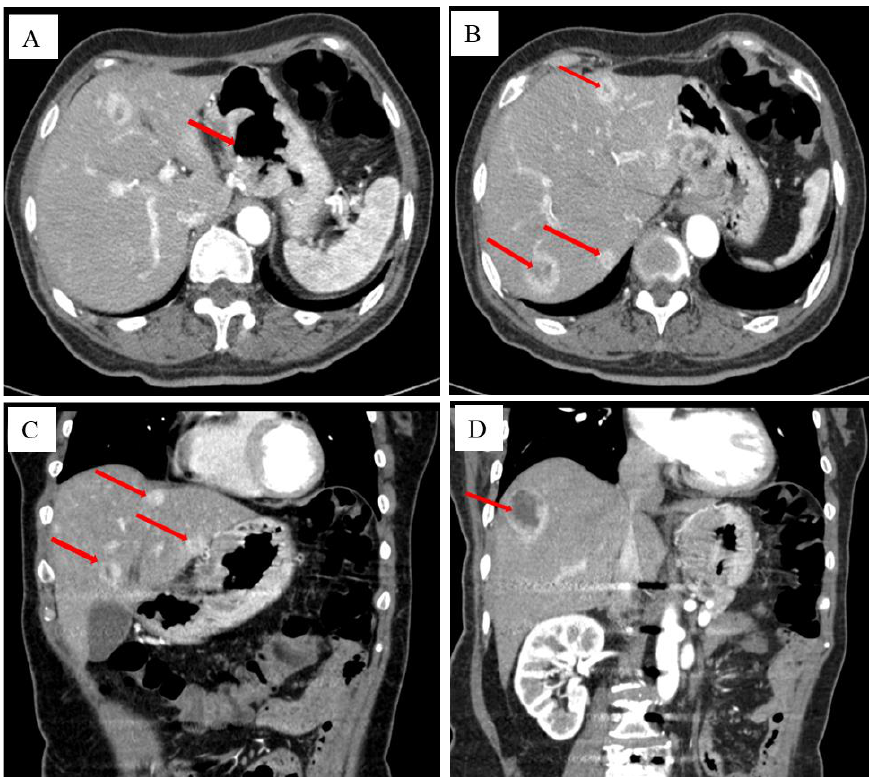
Figure 2. The patient’s results from the CT examination after admission. After the patient was admitted to the hospital, the transverse section of the upper abdomen was imaged using a contrast- enhanced CT, showing gastrointestinal lesions, which are like a volcanic mouth (red arrow) ( A ). The transverse section indicates gastric cancer metastases to the liver (red arrow) ( B ). The median sagittal section shows that gastric cancer is accompanied by liver metastasis (red arrow) ( C ). The coronal section shows that gastric cancer is accompanied by liver metastasis (red arrow) ( D ). The patient is diagnosed with malignant tumours of the gastric gastrointestinal side and ulcers, lymphatic metastasis to the liver and gastrointestinal ligament area, and multiple metastases in the liver. QIAN XH et al. find that GIST is generally considered to originate from the Khalk cell ICC. Most of the GIST occurs in the stomach, followed by small intestines, the colon, and the oesophagus [6]. Malignant GISTs can be transferred to the liver through blood circulation, and those that occur in the liver are basically the gold standard for transferring liver GISTs.